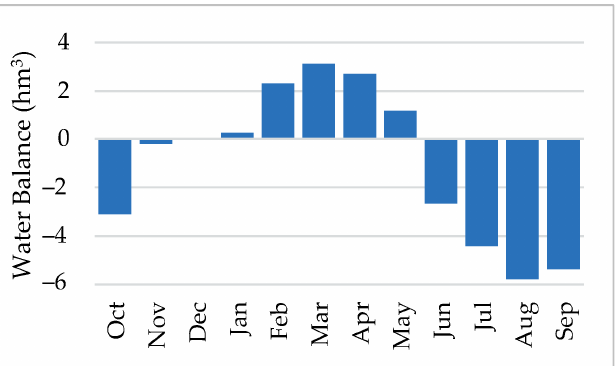
Figure 24. Average monthly water balance of the Almyros basin aquifer for the simulation years 1991–2018.